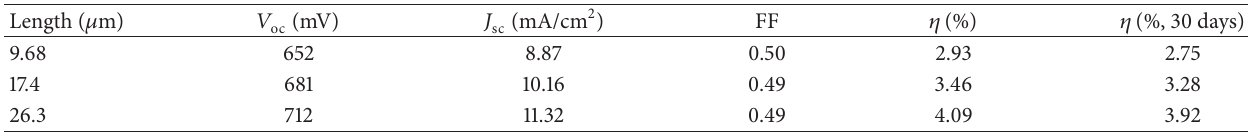
Figure 4: SEM images of 0.5 wt% NH 4 F + 2H 2 O + EG TNT arrays after cleaning, anodization, and annealing for varied periods. Top views for (a) 1h, (c) 3h, and (e) 5h and side views for (b) 1h, (d) 3 h, and (f) 5h, respectively. ), short-circuit current density ( 𝐽 ), fill factor (FF), and efficiency ( 𝜂 ) for solar cells with different Table 1: Values of open-circuit voltage ( 𝑉 oc sc length of the TiO 2